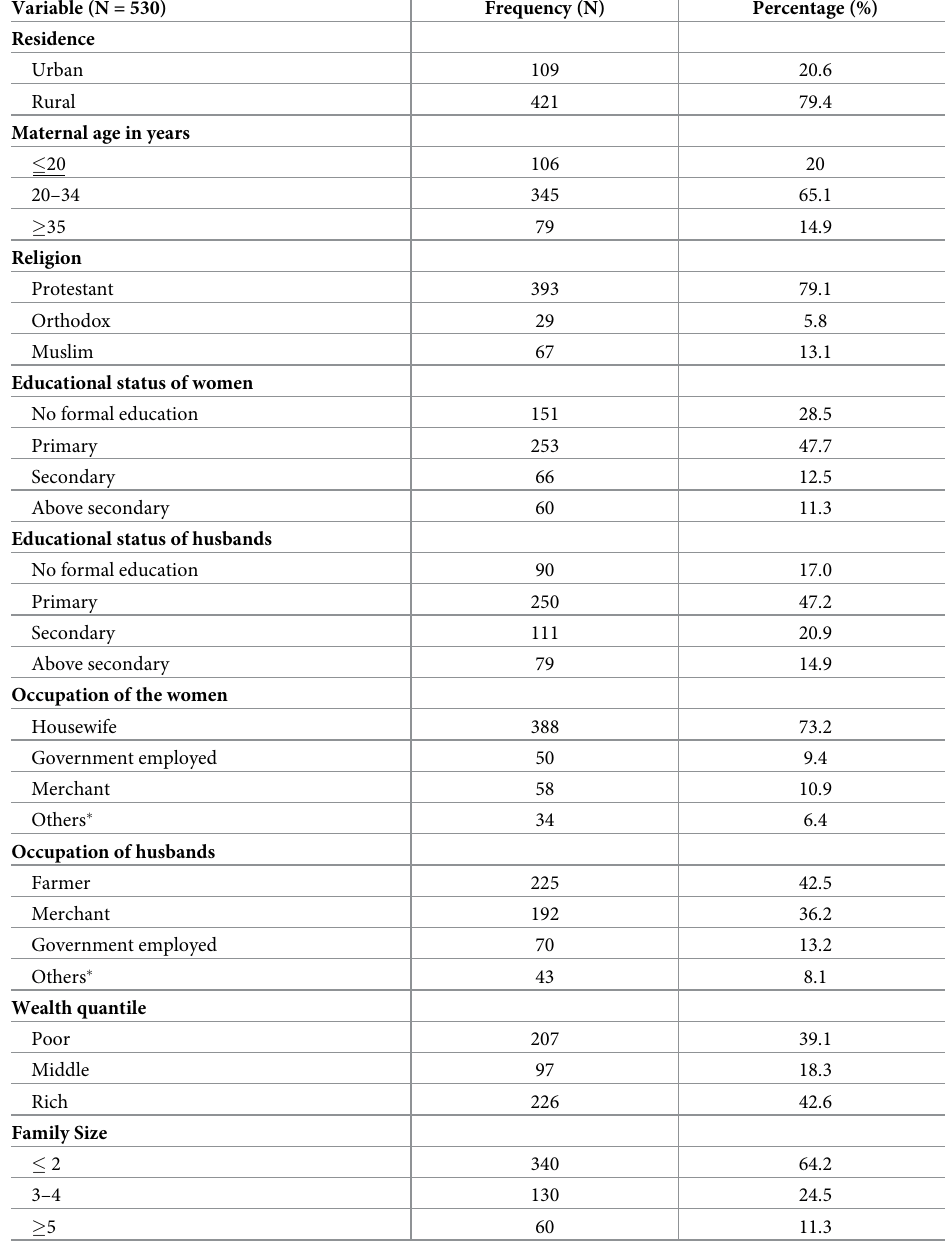
Table 1. Socio-economic and demographic characteristics of the pregnant women Southern Ethiopia, 2020. Variable (N =